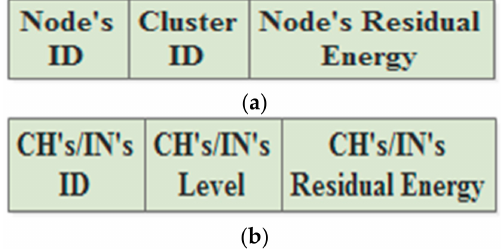
Figure 5. The updated messages in the dynamic approach: ( a ) the N’s message; ( b ) the CH’s/IN’S